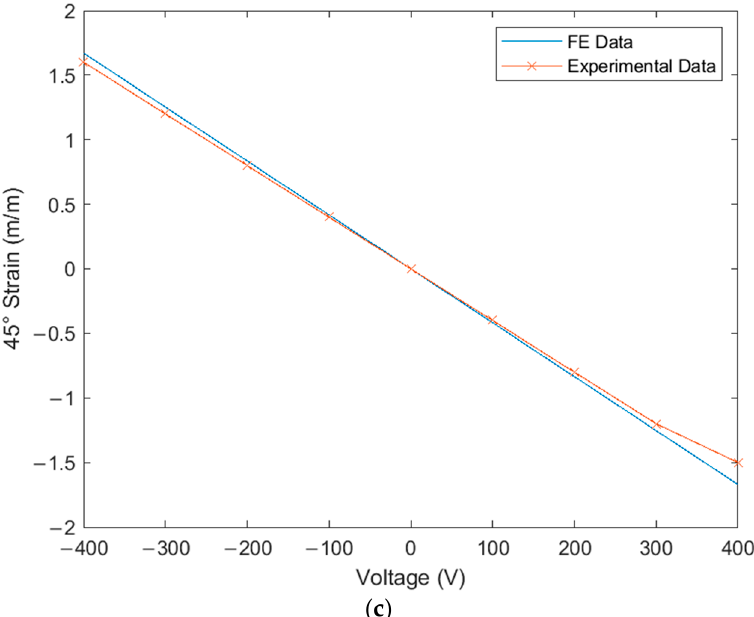
Figure 15. Verification of FE simulation strains (m/m) and experimental strains (m/m) due to MFC actuation in volts (V): ( a ) axial strain ( ε c ); ( b ) transverse strain ( ε a ); ( c ) strain at 45° ( ε b ).